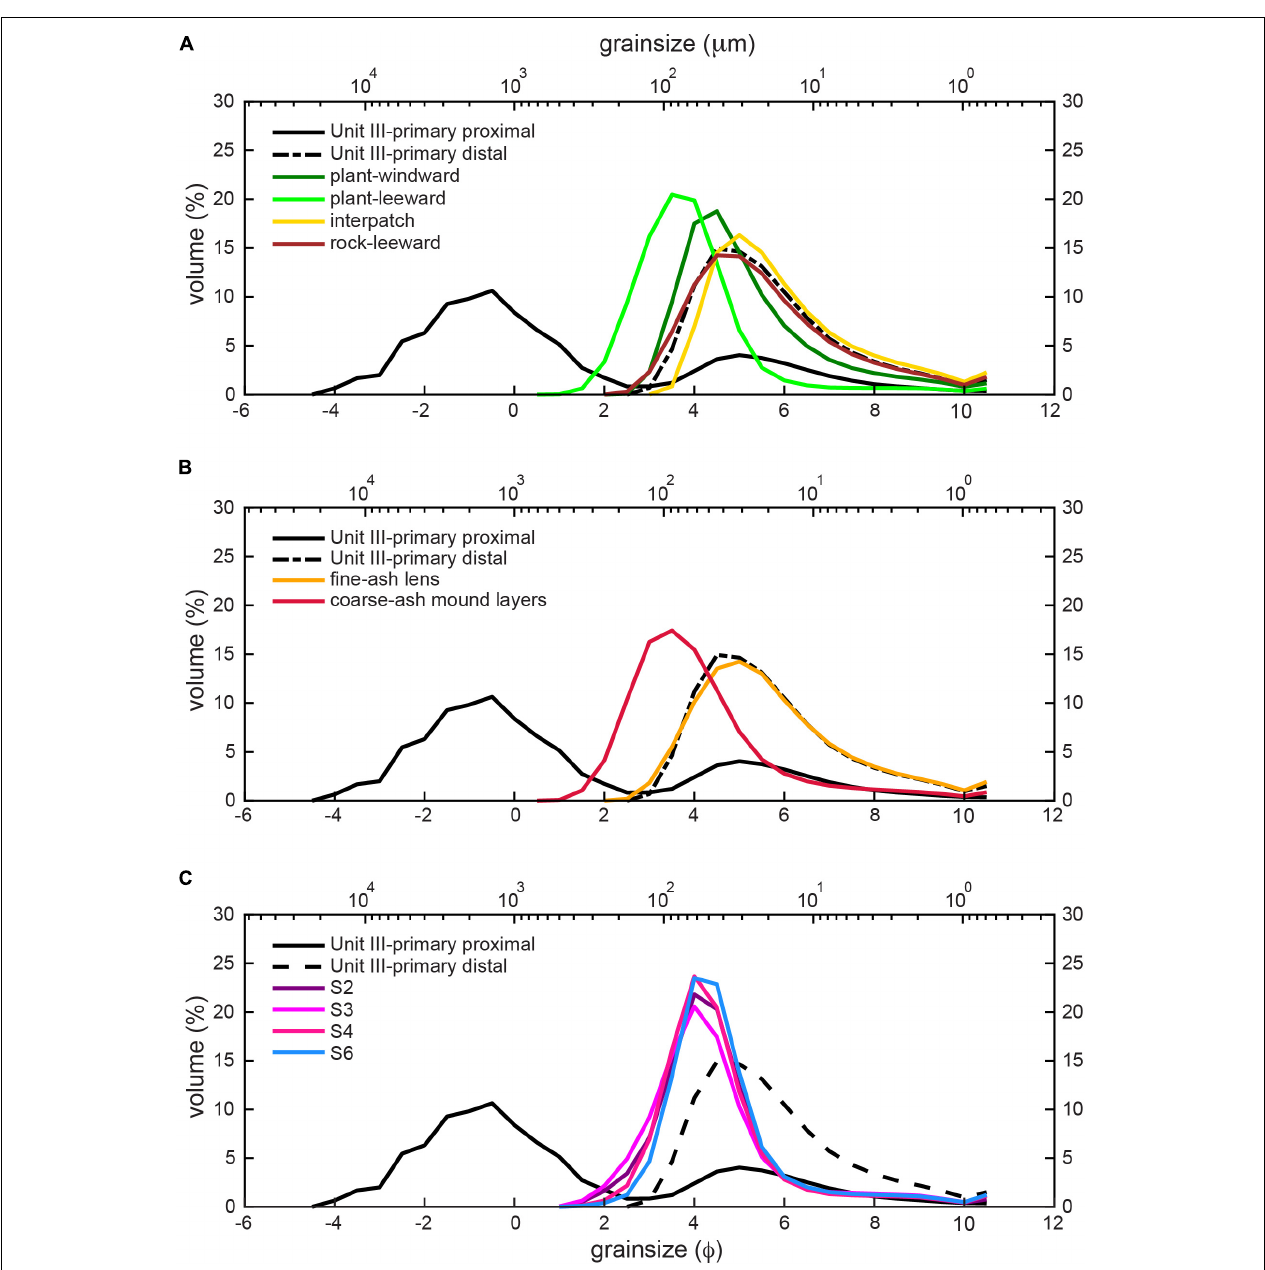
FIGURE 6 | Weight-averaged grainsize distributions of primary tephra fallout (i.e., Unit III – proximal and Unit III – distal corresponding with ∼ 100 and ∼ 300 km from the vent, respectively) and remobilised ash deposits associated with: (A) roughness elements (i.e., ground samples, Dataset 1); (B) pre-existing mounds (i.e., ground samples, Dataset 1); (C) airborne samples for the four selected sites (i.e., Dataset 2). The x -axes are displayed in phi-scale (bottom) and microns (top), φ = –log 2 D/D 0 , where D 0 = 1